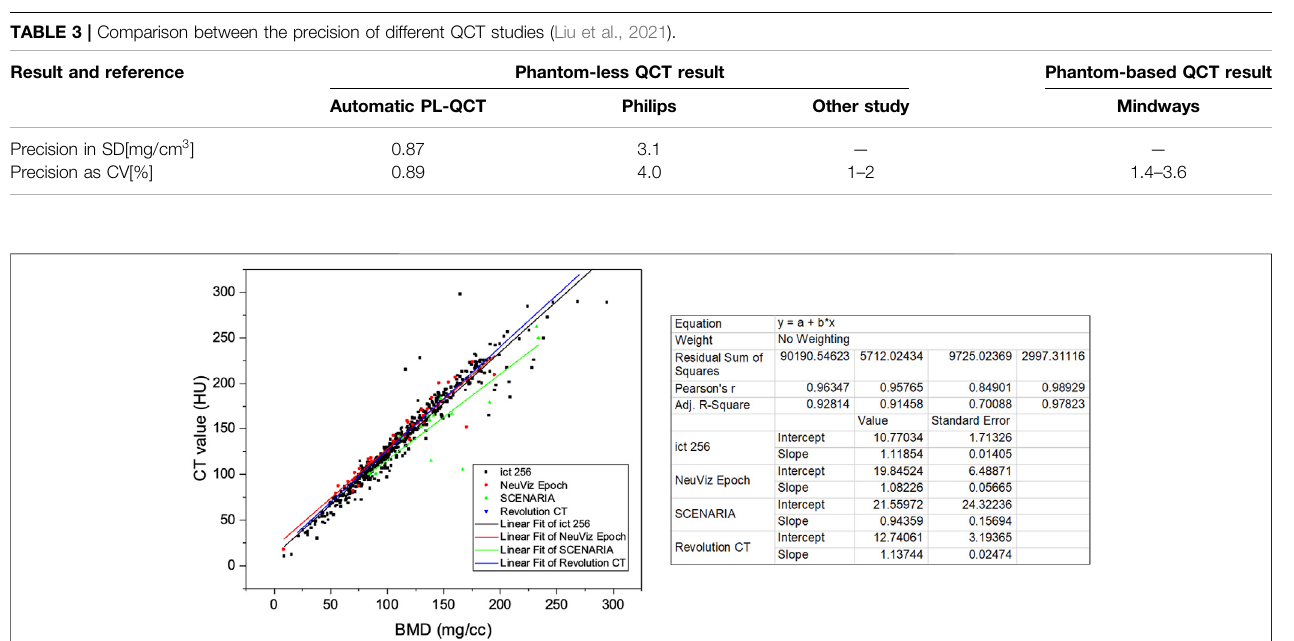
FIGURE 4 | Linear relationship between CT attenuation values and vBMD (mg/cc) of different CT devices.